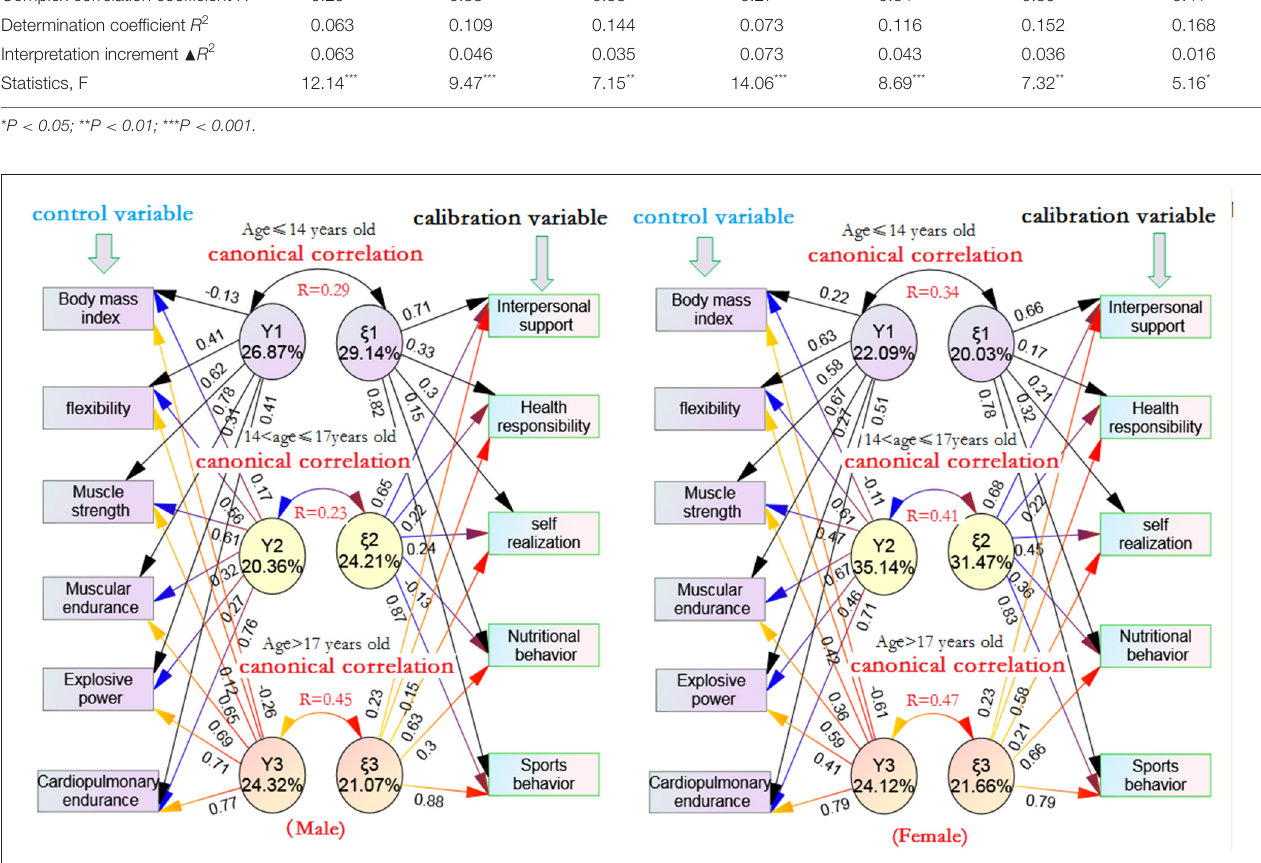
FIGURE 2 | Typical correlation characteristics between health physical fitness and health promoting life of adolescents of different